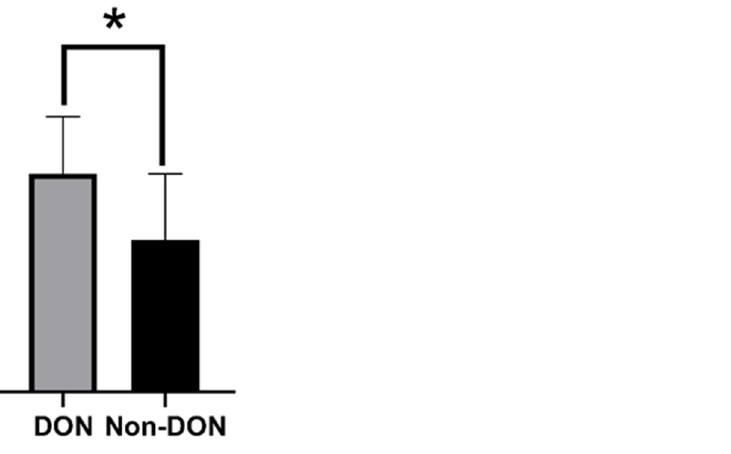
Figure 5. The comparison of the EMV-OA/OAV between DON and non-DON groups (* p < 0.05). 3.4. Distribution by Population about the AMR-ON and ALR-ON The value of AMR-ON and ALR-ON were assigned into five intervals, which are 0 ◦ , <5 ◦ , 5–10 ◦ , 10–15 ◦ , and >15 ◦ . The results showed that the distributions by population of AMR-ON and ALR-ON among TED-NM, non-DON, and DON subjects were significantly different ( p < 0.05, Tables 3 and 4). In the TED-NM group, AMR-ON was mainly distributed in the 10–15 ◦ interval (50%), and ALR-ON mostly in the >15 ◦ interval (73%). AMR-ON was mostly zero in DON patients (80%), whereas ALR-ON was larger in non-DON patients (Figures 6 and 7). Table 3. Population distribution of the angle between the medial rectus and optic nerve (AMR-ON). AMR-ON TED-NM (orbits, %) non-DON DON TED-IM (orbit number, %) AMR-ON: the angle between medial rectus and optic nerve. Table 4. Population distribution of the angle between the lateral rectus and optic nerve (ALR-ON). ALR-ON TED-NM (orbit number, %) TED-IM (orbit number, %) ALR-ON: the angle between lateral rectus and optic nerve.